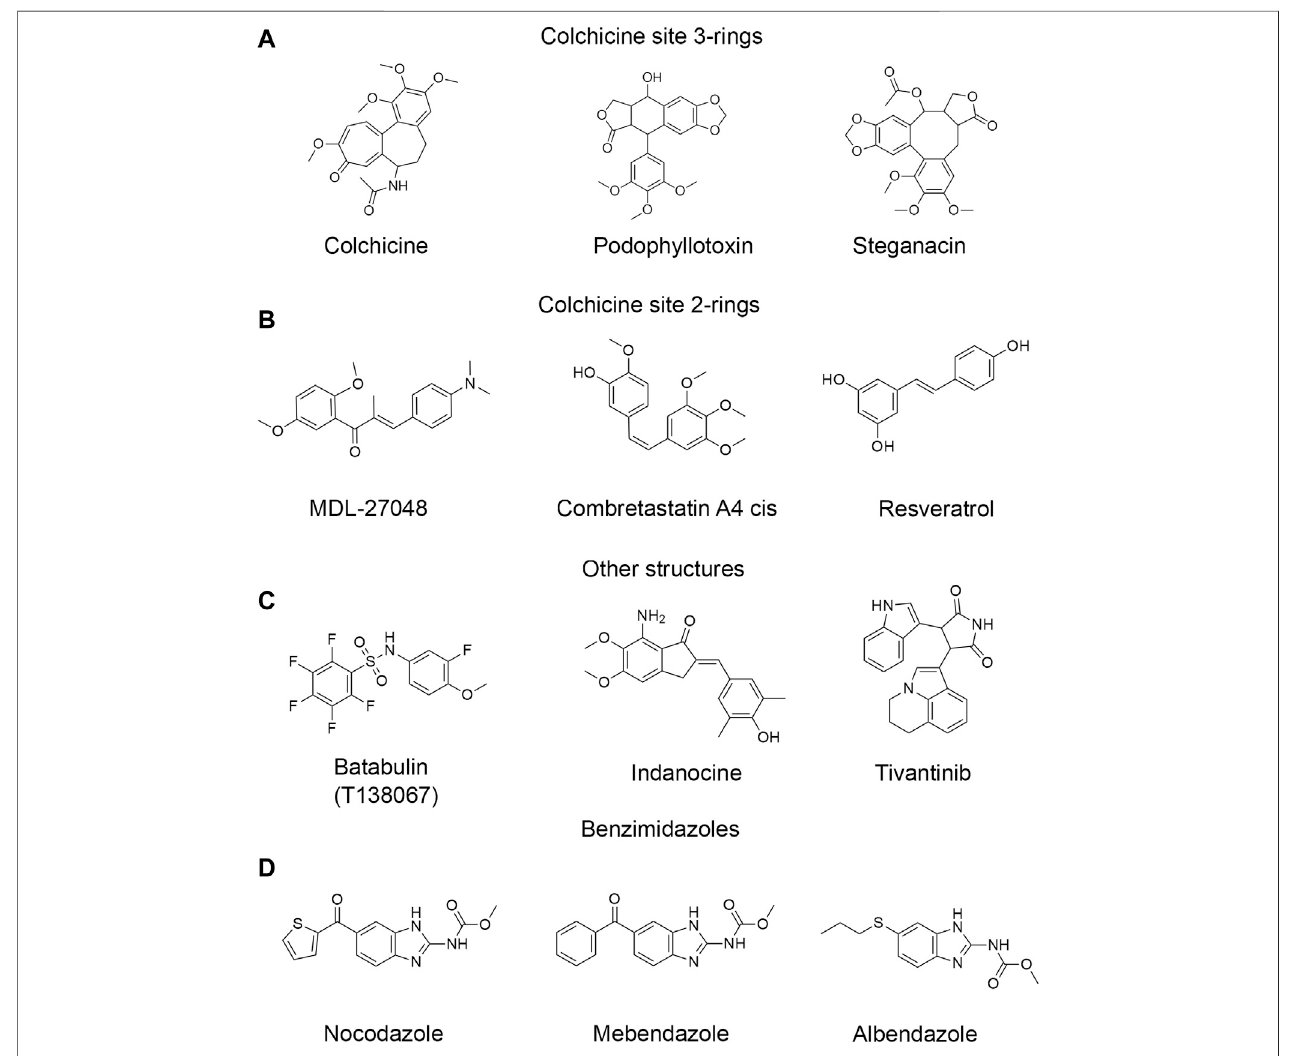
FIGURE 1 | Structures of representative colchicine site drugs used in this work. (A) colchicine site 3-ring drugs: colchicine, podophyllotoxin and steganacin. (B) colchicine site 2-ring drugs: MDL, combretastatin A4 cis, resveratrol. (C) drugs with other non-colchicine structures: tubulazole C, indanocine, tivantinib. (D) benzimidazole drugs: nocodazole, carbendazim, oxibendazole. Full list of drugs structures is found in Supplementary Figures S1 – S4 .